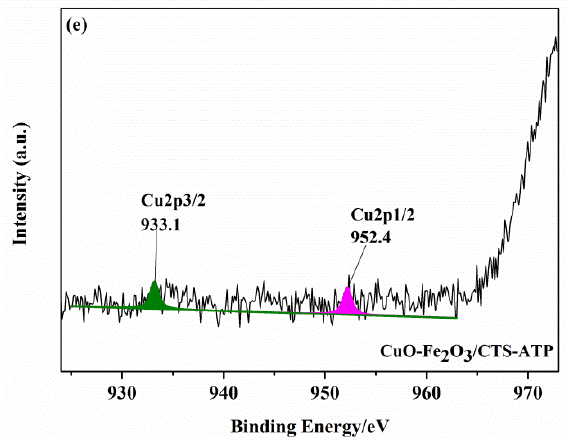
Figure 4. XPS full spectra ( a ), C1s spectra ( b ), O2p spectra ( c ), Fe2p spectra ( d ), and Cu2p spectra ( e ) of prepared catalysts.